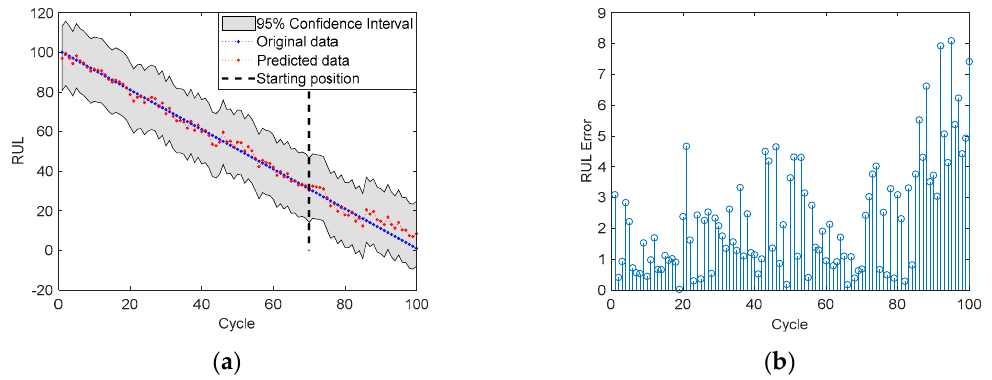
Figure 16. RUL prediction results for battery No. 18 with SP = 71: ( a ) RUL; ( b ) RUL prediction Error.